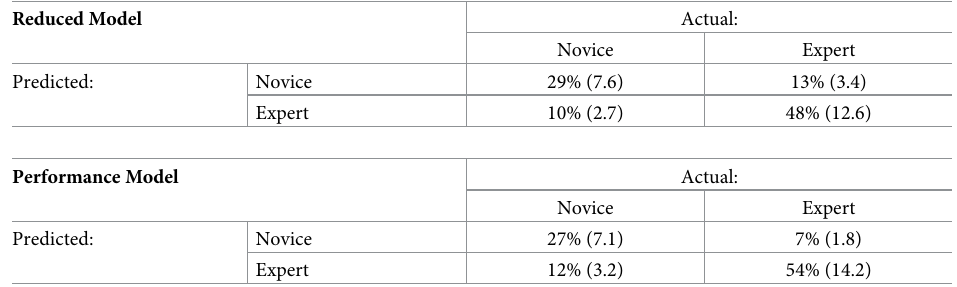
Table 3. Confusion matrices showing average cell counts across independent test sets for the reduced and perfor- mance logistic regression